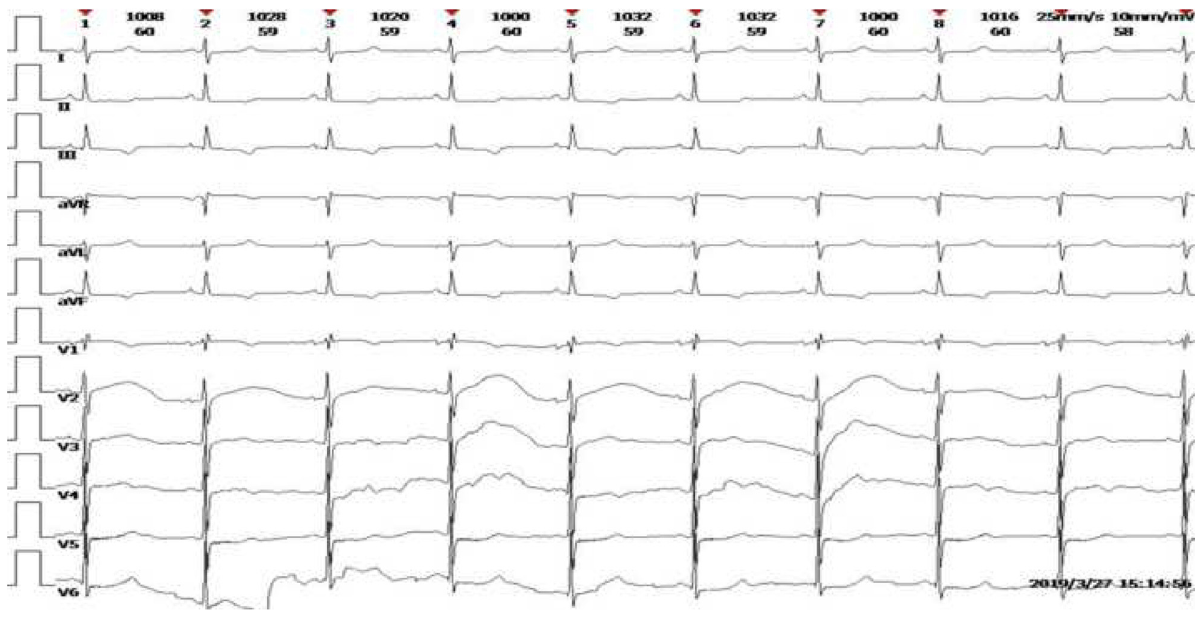
Figure 4: ECG showed ST - T abnormality after 3 months of admission.